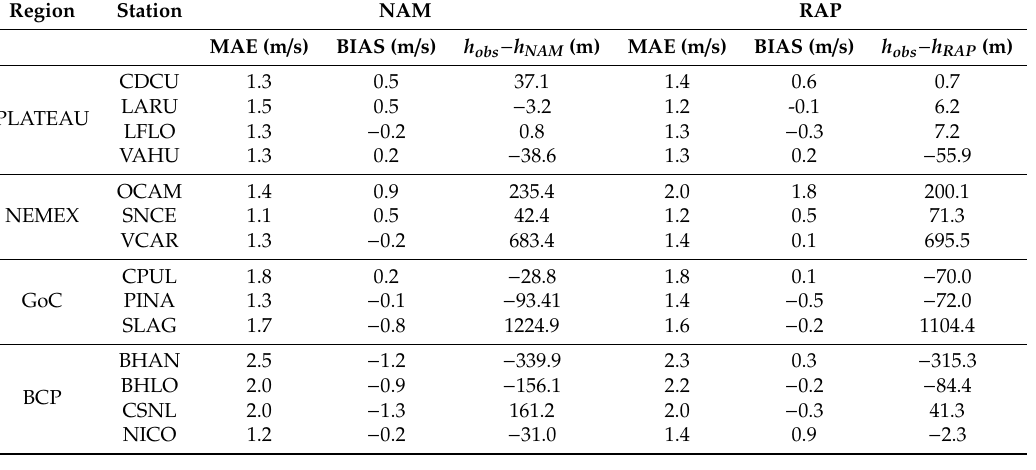
Table 3. Mean absolute error, bias and altitude di ff erence for NAM and RAP in Plateau, NEMEX, GoC and BCP.